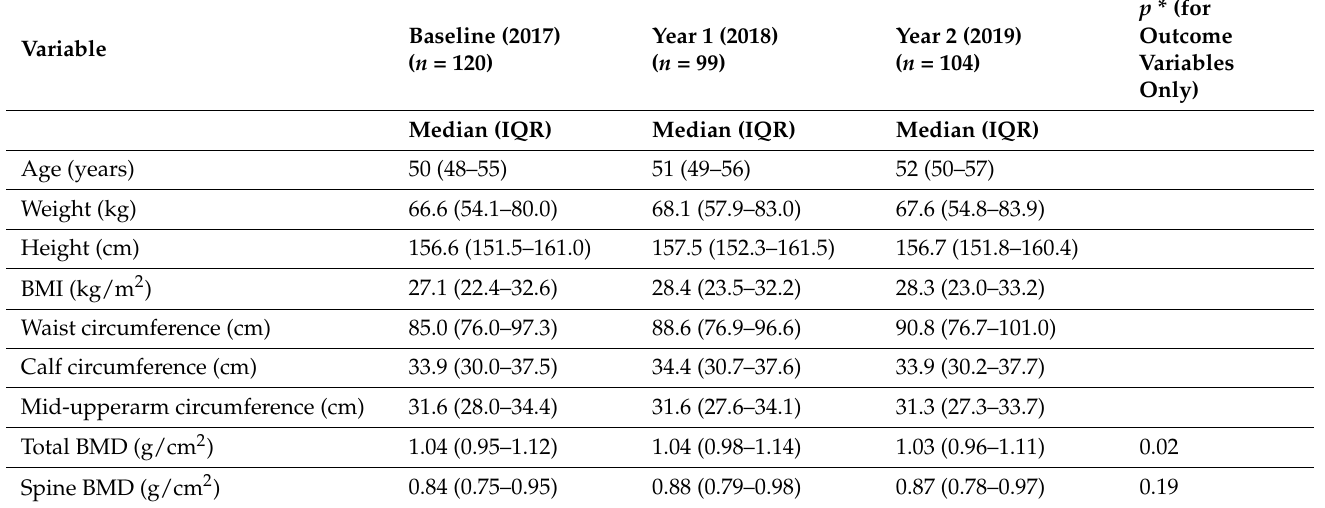
Table 1. Study participants’ characteristics from baseline to 2-year